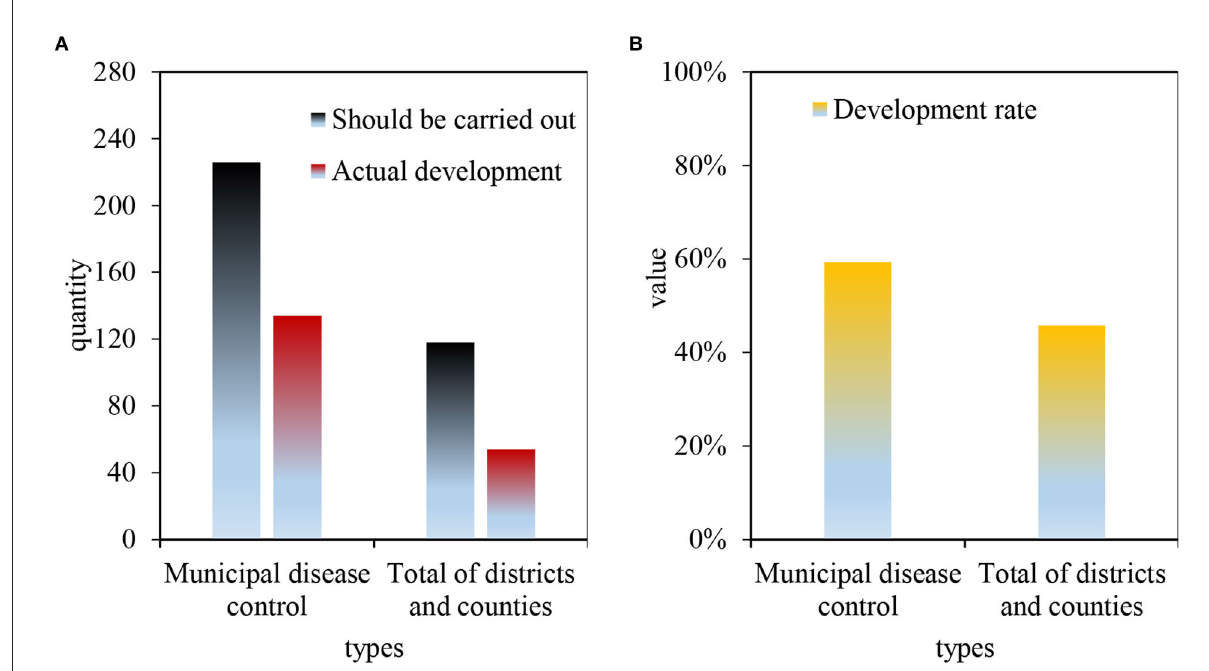
FIGURE6 Work items that must be carried out by disease control institutions in M City. (A) Projects that should be carried out and actually carried out by the CDC in M City. (B) Project implementation rate of disease control agencies in M